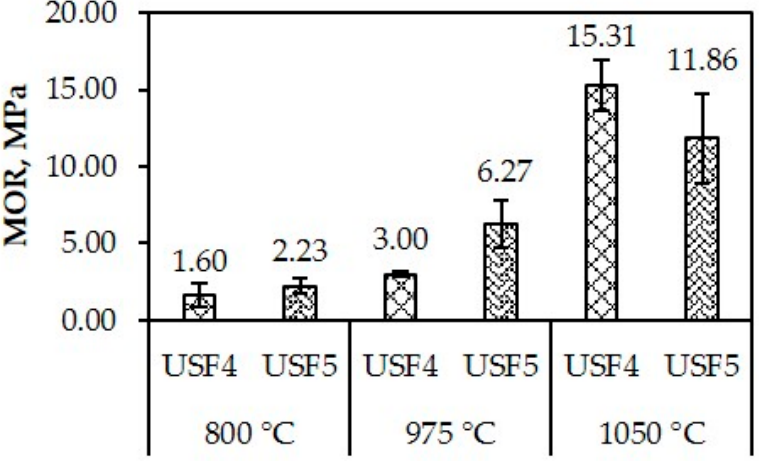
Figure 9. Results on modulus of rupture at different sintering temperature. This study showed that Nickel laterite mine waste could be utilized as raw materials for both wall and floor tiles across various standards. Feldspar could be added to enhance casting to form NMW tiles. In terms of relative amount of valorization of waste, 10 wt% and 12 wt% were utilized for tiles with river silt and bricks with dredging sediment, respectively. These values are lower compared to the tiles with NMW, which employed at least three-fold their amount. This could add value to the voluminous amount of NMW than just being stored in many siltation ponds that consistently require high